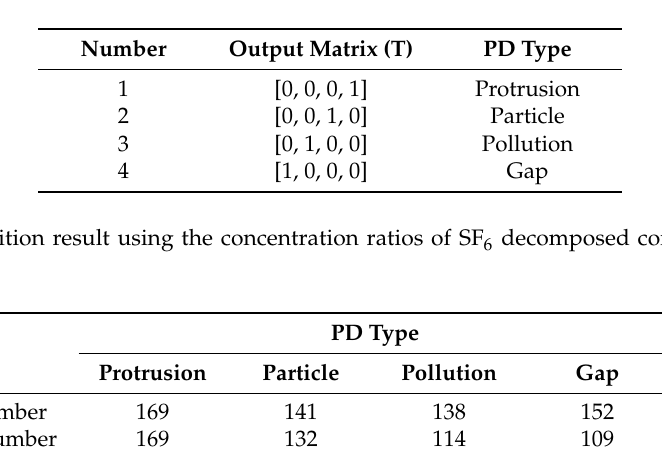
Table 5. Output matrix of BP neural network.